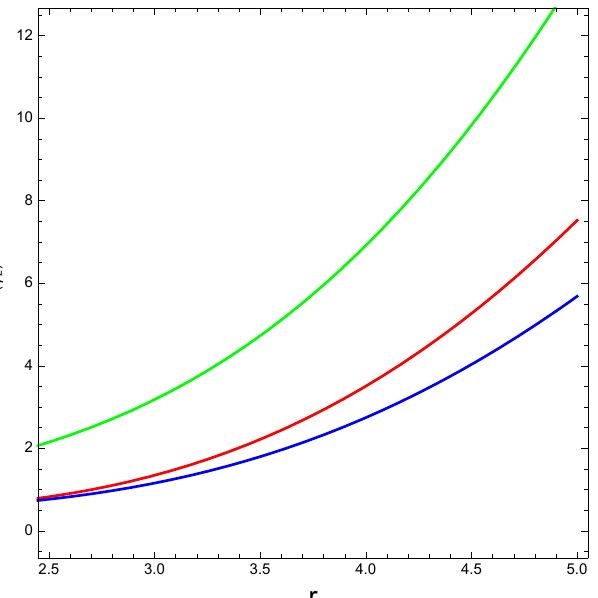
Figure 13. Solution of the scalar potential for R adopted as an exponential function of radius. The evolution of the scalar potential V ( φ 2 ) is obtained by comparing Equation (7) and Equation (32). We have fixed the values of η 2 , η 3 , a 0 , a 1 , a 2 , K , and C 1 . The red, green, and blue lines correspond to small perturbations of λ 0 , Ψ 0 , and η 1 ,